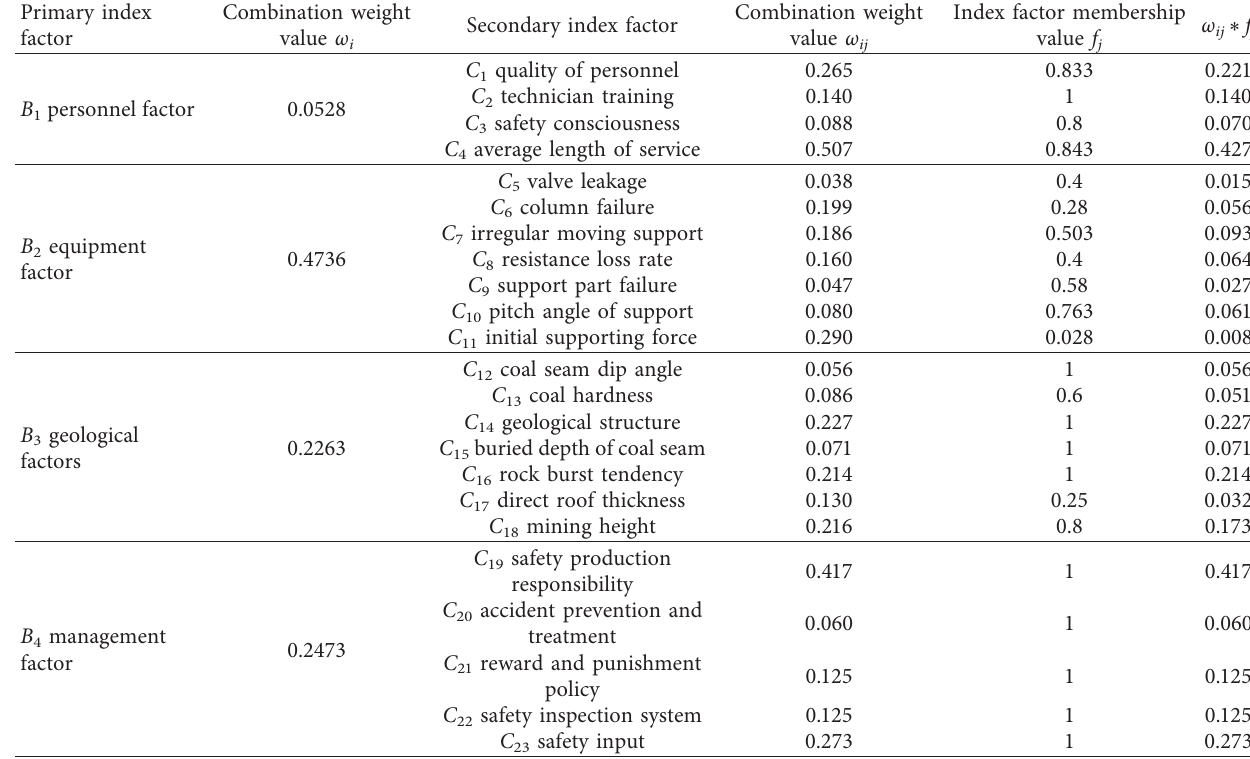
Table 4: Various parameters of index factors.